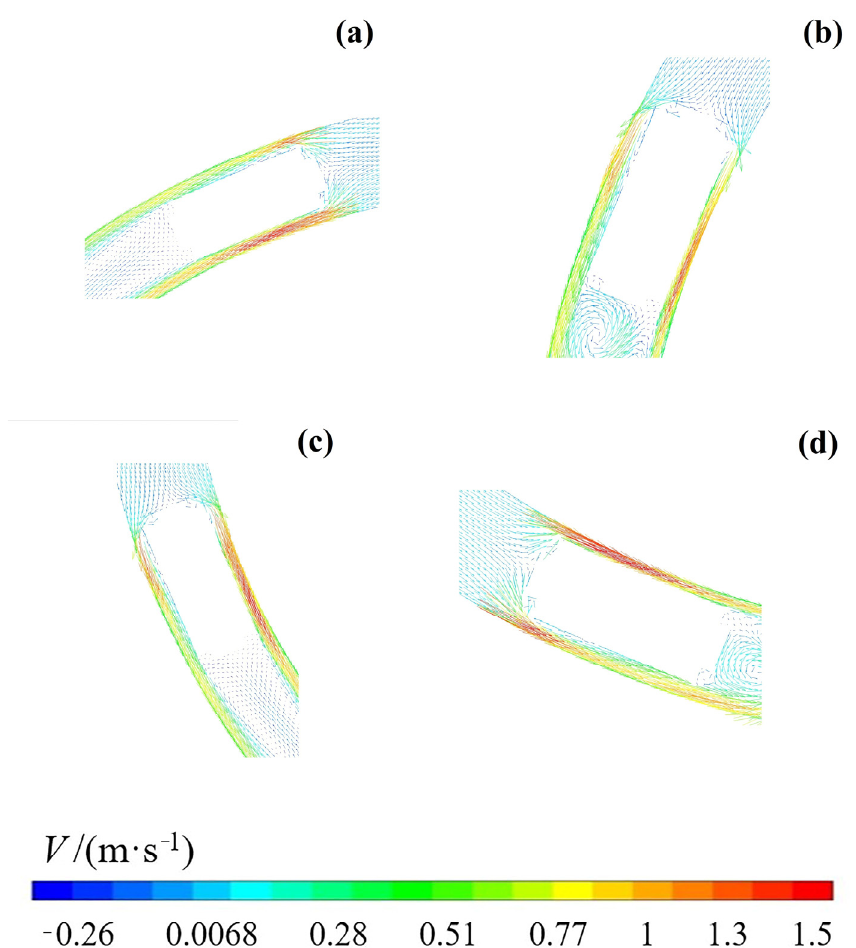
Figure 7. The vector diagram of the water flow velocity in the XOZ plane (the horizontal plane where the pipe axis is located), the centroid of the wheeled capsule had angle locations of θ : ( a ) First condition θ = 22.5°; ( b ) Second condition θ = 67.5°; ( c ) Third condition θ = 112.5°; ( d ) Fourth condition θ = 157.5°.